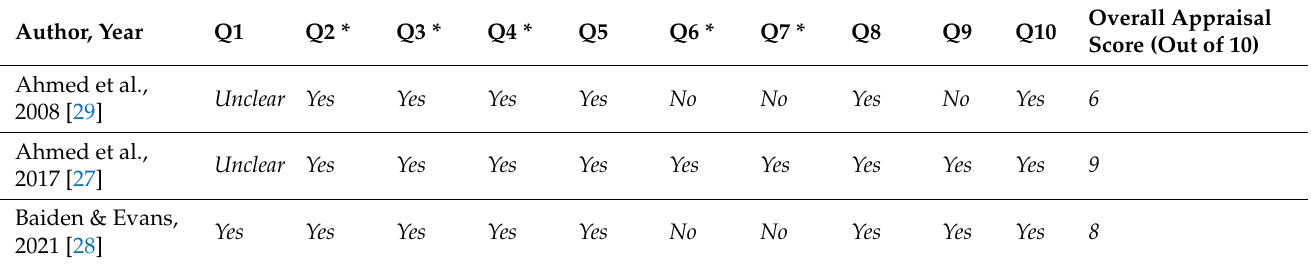
Table 3. JBI Quality Appraisal